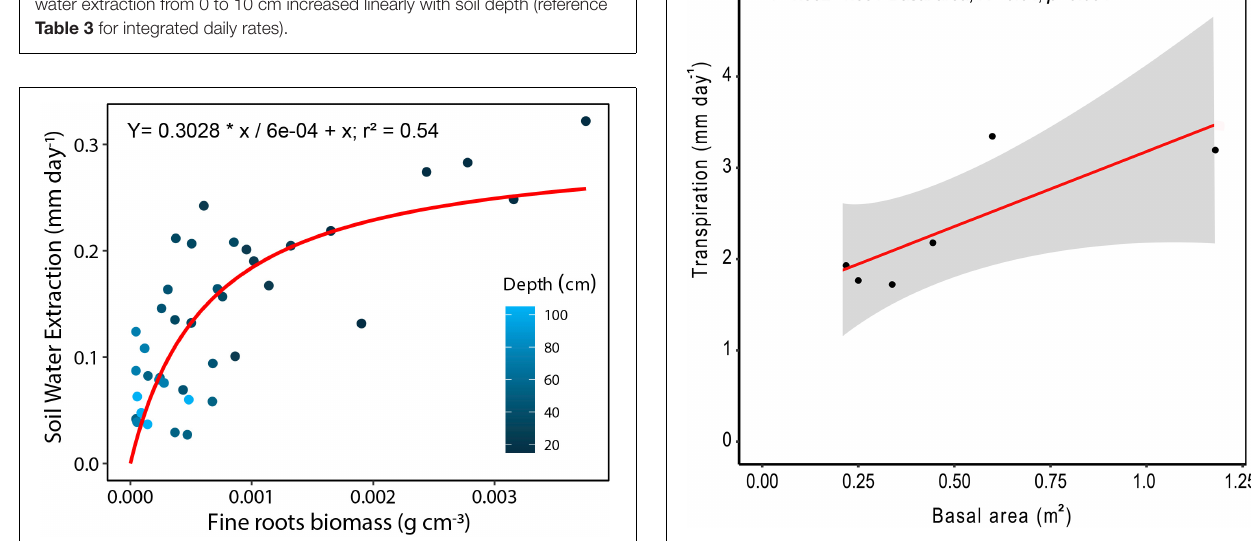
FIGURE 9 | Average daily water use for all trees within each 10 m diameter sample plot based on the allometric scaling of tree basal area in central Amazonia. The shaded area represents the 95% confidence